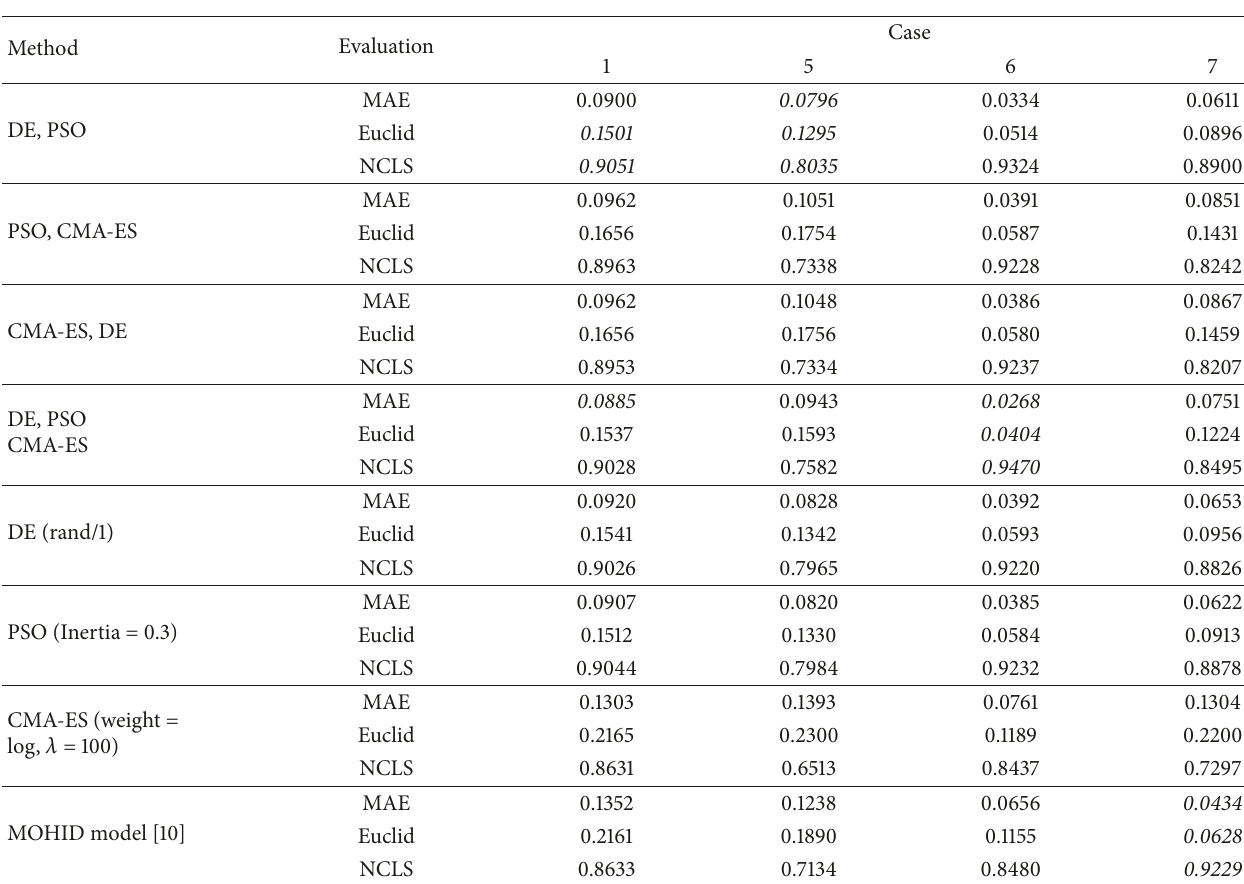
Table 12: Results on parameters of all the tested